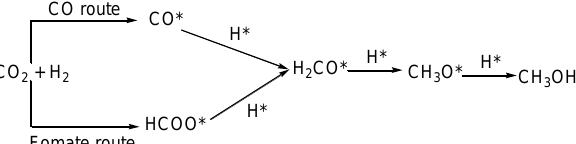
Figure 8. Reaction route for CO 2 hydrogenation to methanol over MoS 2 -45@C.